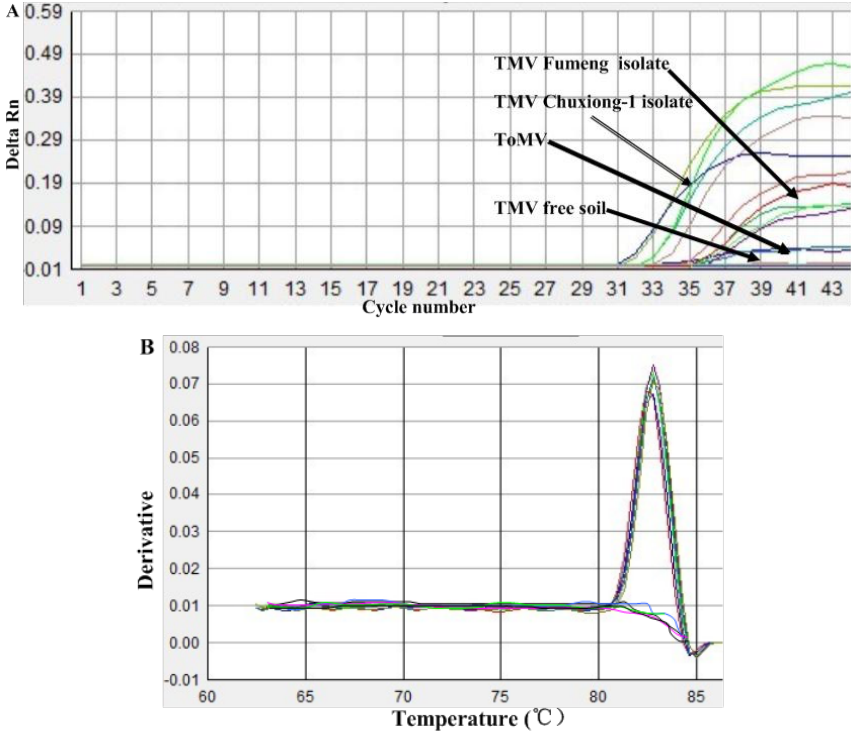
Figure 3. The specificity of IC-real-time RT-PCR for the detection of TMV in soil. The specificity of the IC-real-time RT-PCR assay as monitored by amplified curve ( A ) and melting curves ( B ) for TMV CP gene. (A) Amplified curve shown from left to right are the curves of TMV Fumeng isolate, TMV Chuxiong-1 isolate, ToMV and TMV-free soil. (B) Melting curves for TMV CP gene with single peak from three replicates of two different templates including TMV leaves and viruliferous soils.